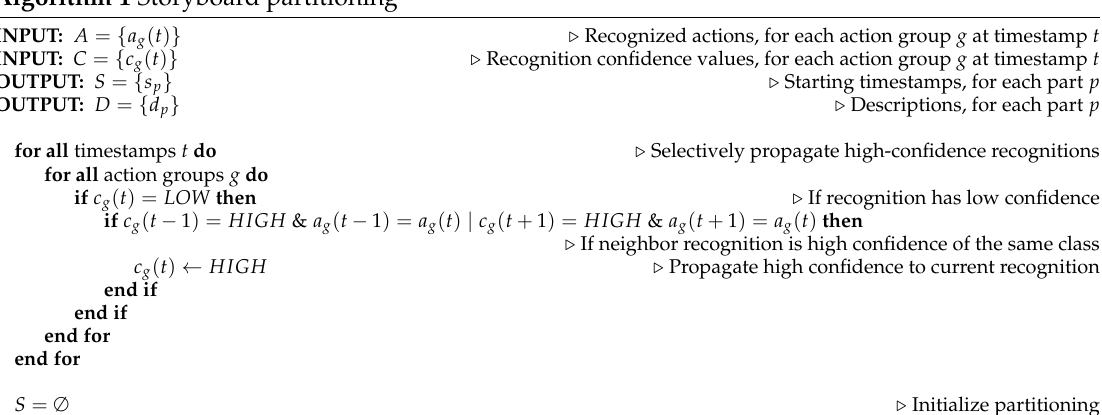
Algorithm 1 Storyboard